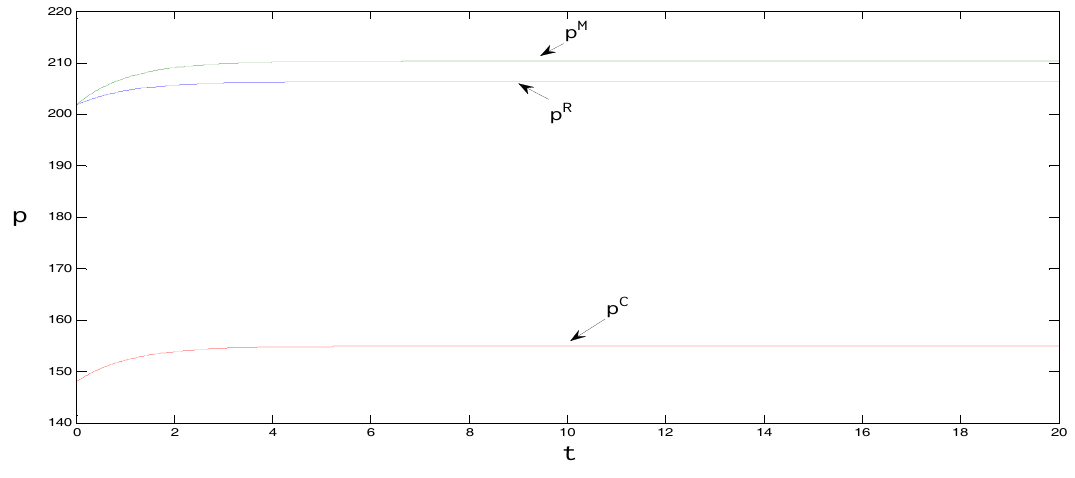
Figure 2. Comparison of retail prices.